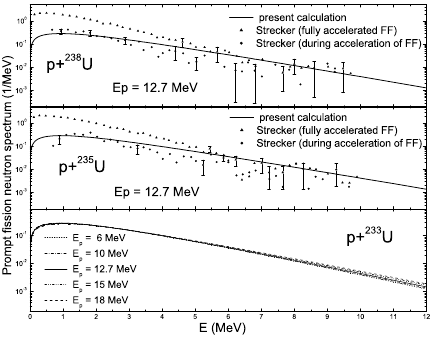
Fig. 4. The prompt neutron fission spectra of 234 , 236 , 239 Np isotopes at di ff erent proton incident energies E p compared with the exper- imental